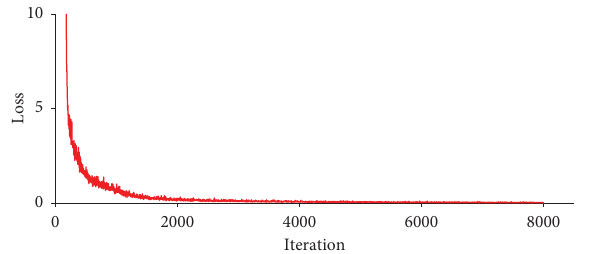
Figure 8: The iterative convergence process of the Loss curve for YOLOv3 network training.